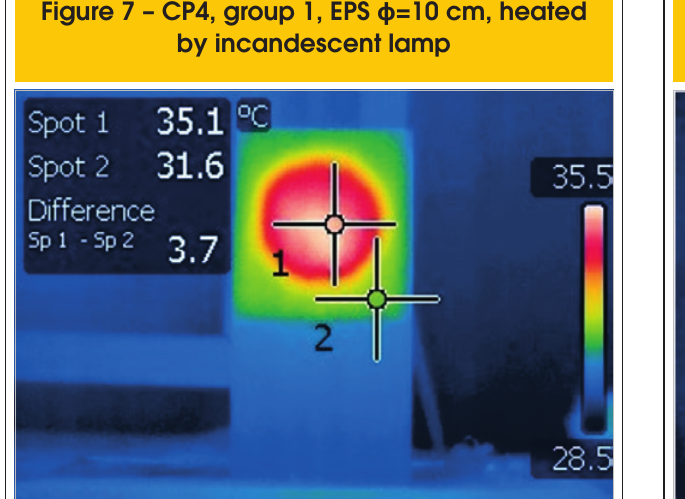
Figure 7 – CP4, group 1, EPS ϕ =10 cm, heated by incandescent lamp